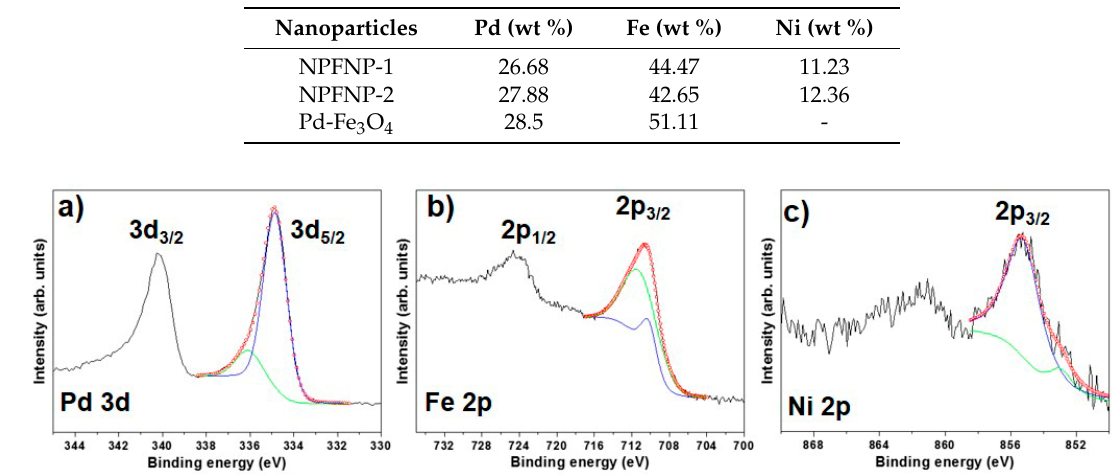
Figure 3. XPS spectra of NPFNP-2 ( a ) 3d 5/2 and 3d 3/2 lines of Pd; ( b ) 2p 3/2 and 2p 1/2 lines of Fe; ( c ) 2p 3/2 lines of Ni.